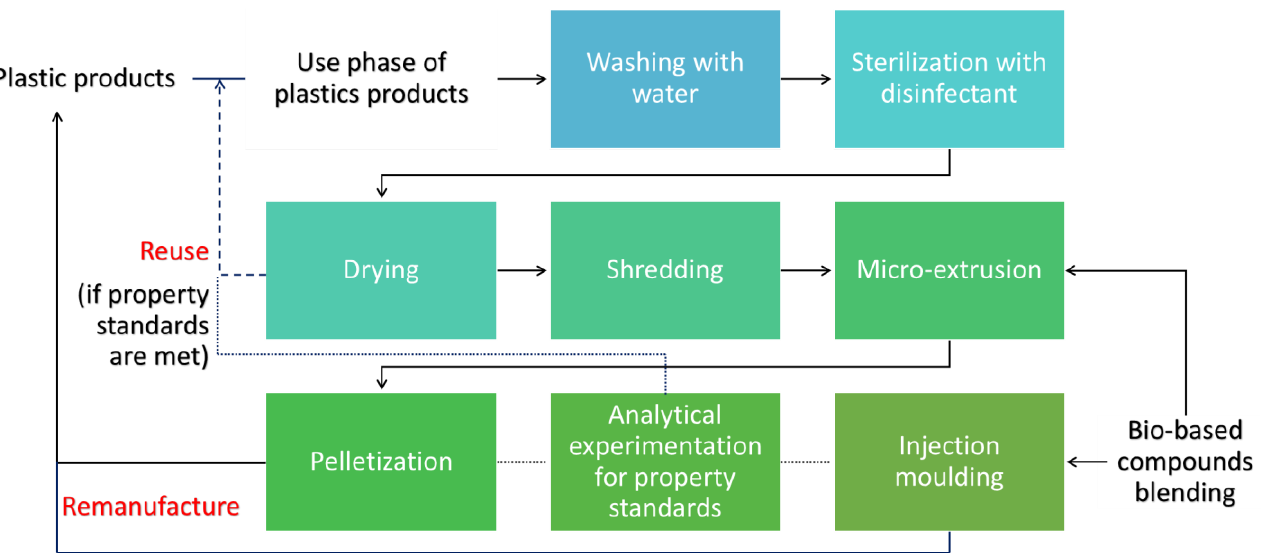
Figure 3. Plastics reuse and remanufacturing for a circular economy system.